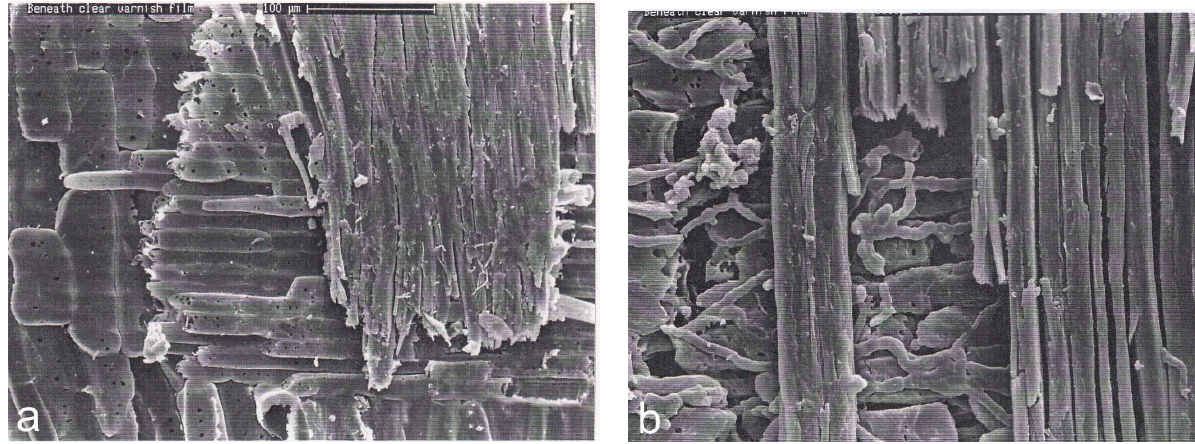
Figure 2. Formation of pit micro-checks and longitudinal separation of tracheids at wood surfaces exposed to weathering: ( a ) Pit micro-checking (arrowed left and right of centre) at the surface of western hemlock wood exposed to natural weathering for 62 weeks. Note the colonization of the surface by staining fungi; ( b ) Deep pit micro-checking (arrowed left and right of centre) at the surface of western hemlock wood exposed to artificial accelerated weathering for 4000 h. There is also separation of tracheids from the underlying wood due to degradation of middle lamellae.